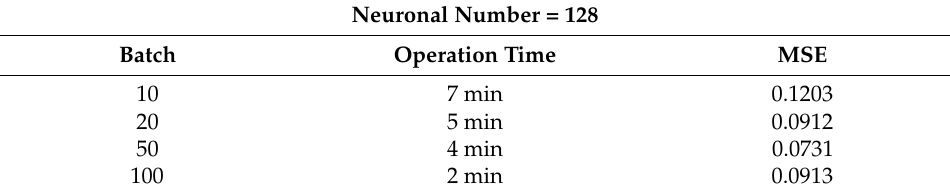
Table 3. LSTM layer prediction results.